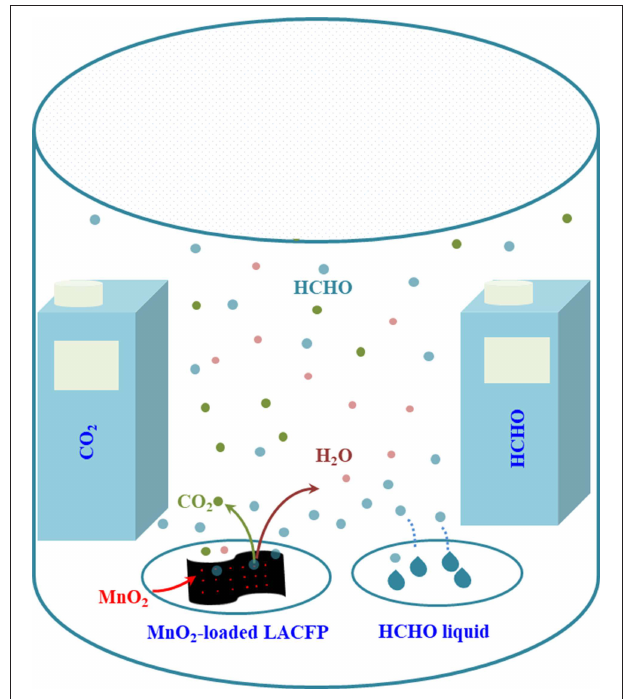
FIGURE 1 | Schematic diagram of the device for catalytic degradation reaction of formaldehyde using MnO 2 -loaded LACFP.